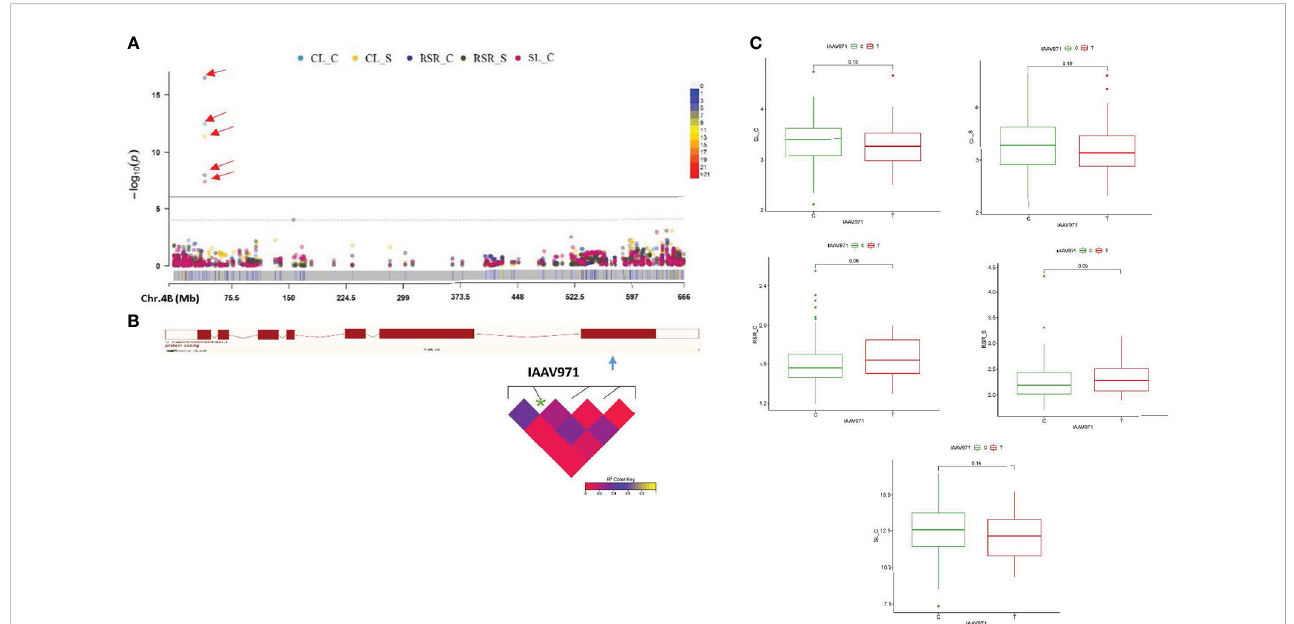
FIGURE 5 A Manhattan plots showing signi fi cant QTN (quantitative trait nucleotides) in 261 winter wheat genotypes for seedling growth parameters under (C) control and (S) drought stress (A) (CL_C, CL_S, RSR_C, RSR_S, and SL_C): CL, coleoptile length; RSR, root to shoot ratio; and SL, shoot length. Multitraits QTNs are indicated as (P<0.001; -log 10 > 3). (B) the structure of the TraesCS4B02G051900 gene with the position of the co-located QTN on 4B (40746325-40753688 bp) and the linkage disequilibrium (LD) interval, and (C) QTN -gene haplotype